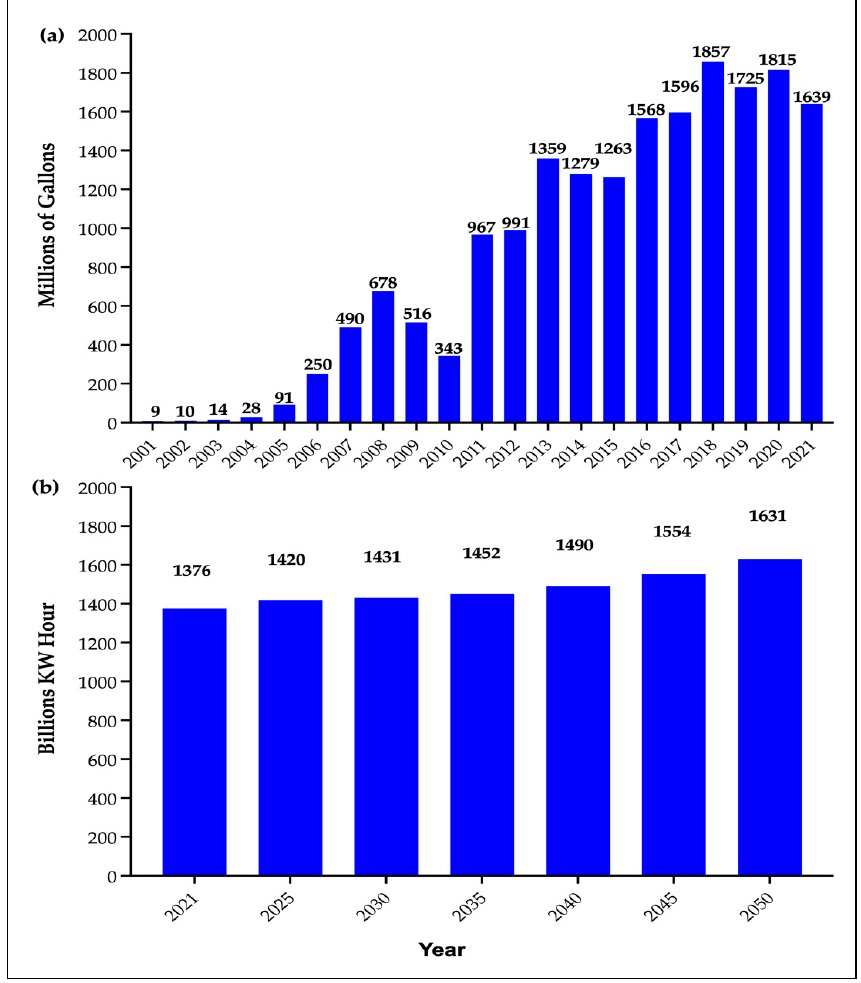
Figure 2. ( a ) US biodiesel production change for the past 20 years since 2001 [61] (Source: U.S. Energy Information Administration (EIA), Monthly Energy Review, Table, 10.4. Release date: April 2022. Available at: https://www.eia.gov/totalenergy/data/monthly/pdf/mer.pdf), and ( b ) US biomass energy production forecast from 2021 to 2050 [62] (Source: EIA, Annual Energy Outlook 2022, Table 1. Available online: https://www.statista.com/statistics/264029/us-biomass-energy-production/. Accessed on 21 June 2022).